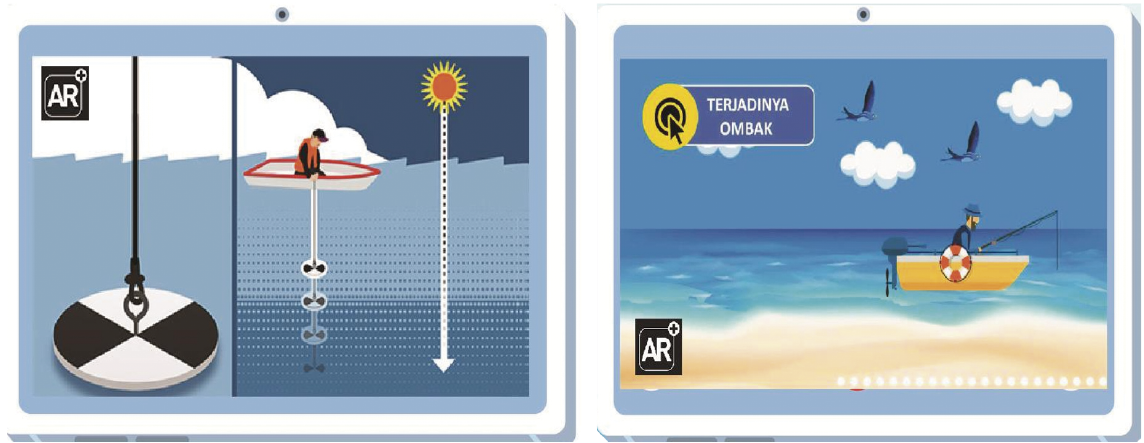
Figure 3. Screenshots of experiments in the ARI on the measurement of the of light and